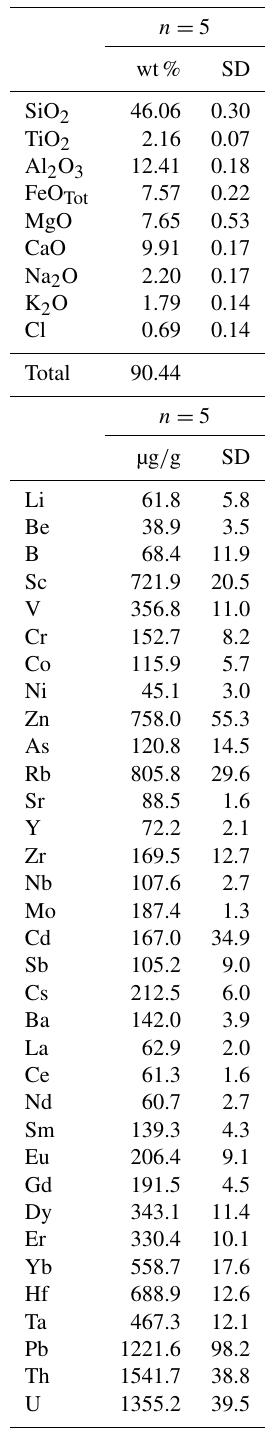
Table 1. Concentrations of major and trace elements in the starting glass (liquid) at 1300 ◦ C (exp